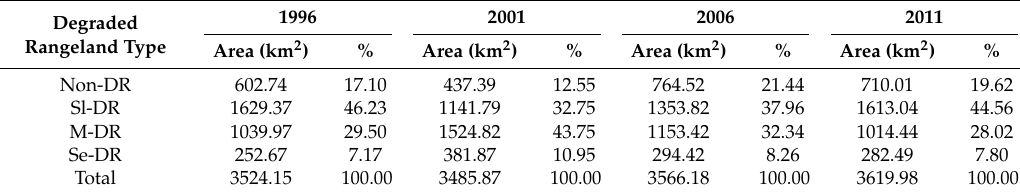
Table 3. Summary of degraded rangeland area statistics in 1996, 2001, 2006, and 2011 for Linxia rangeland.